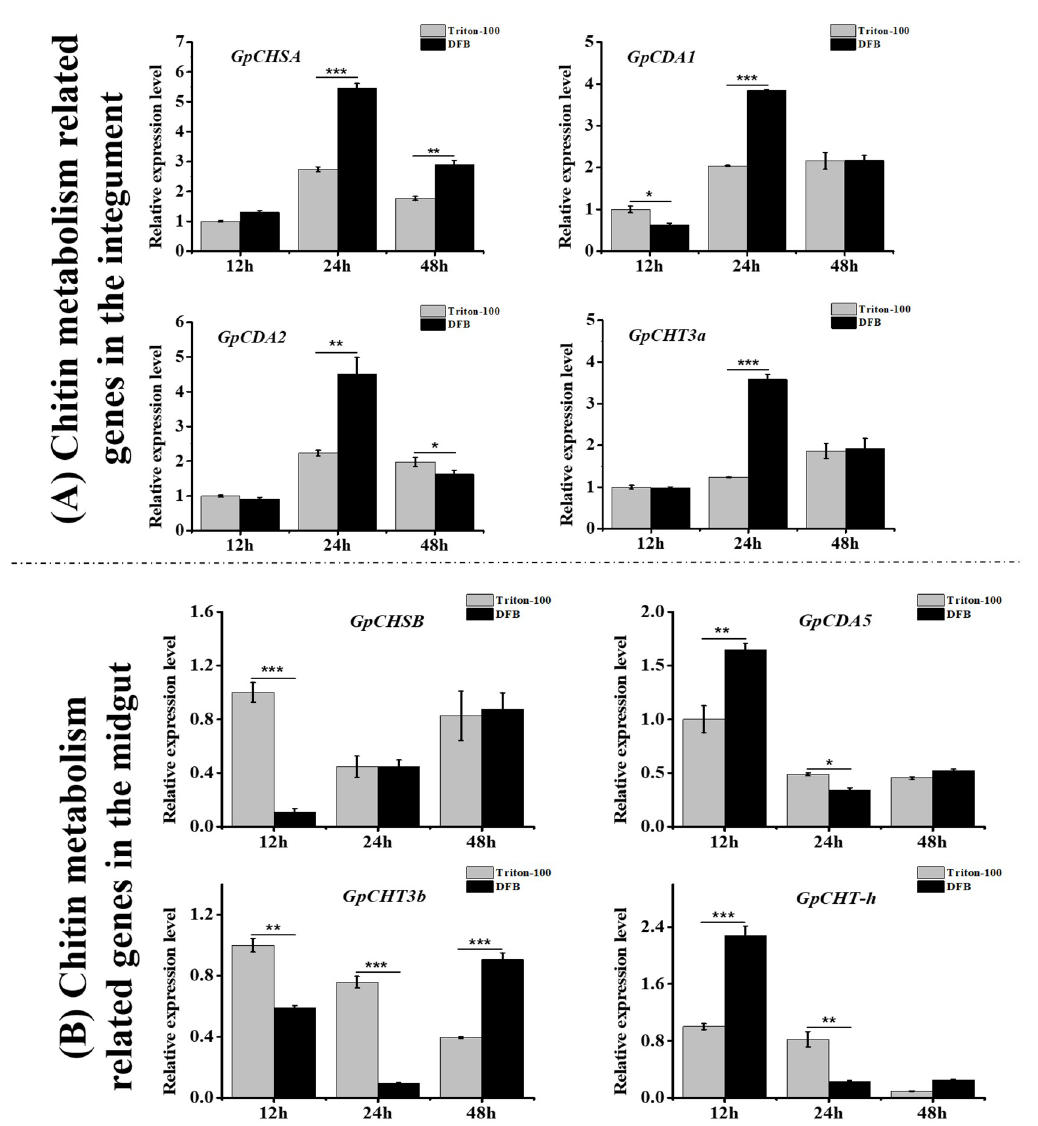
Figure 8. Assessment of expression levels of GpCHSA , GpCHSB, and their downstream genes post-DFB treatment. ( A ) Expression of GpCHSA and its downstream genes in the integument. ( B ) Expression of GpCHSB and its downstream genes in the midgut. GpRpl32 was used to normalize the data that are showed as mean ± standard error, the mean is the triple independent repeats. The 2 − ∆∆ C t method was adopted to calculate the relative expression level. Di ff erences among triple repeats were analyzed using one-way analysis of variance (Systat, Inc., Evanston, IL) with Tukey’s post-hoc test using R version 4.0.0. Asterisks represent the significant di ff erence, as follows: * p < 0 .05; ** p < 0 .01; *** p < 0 .001.